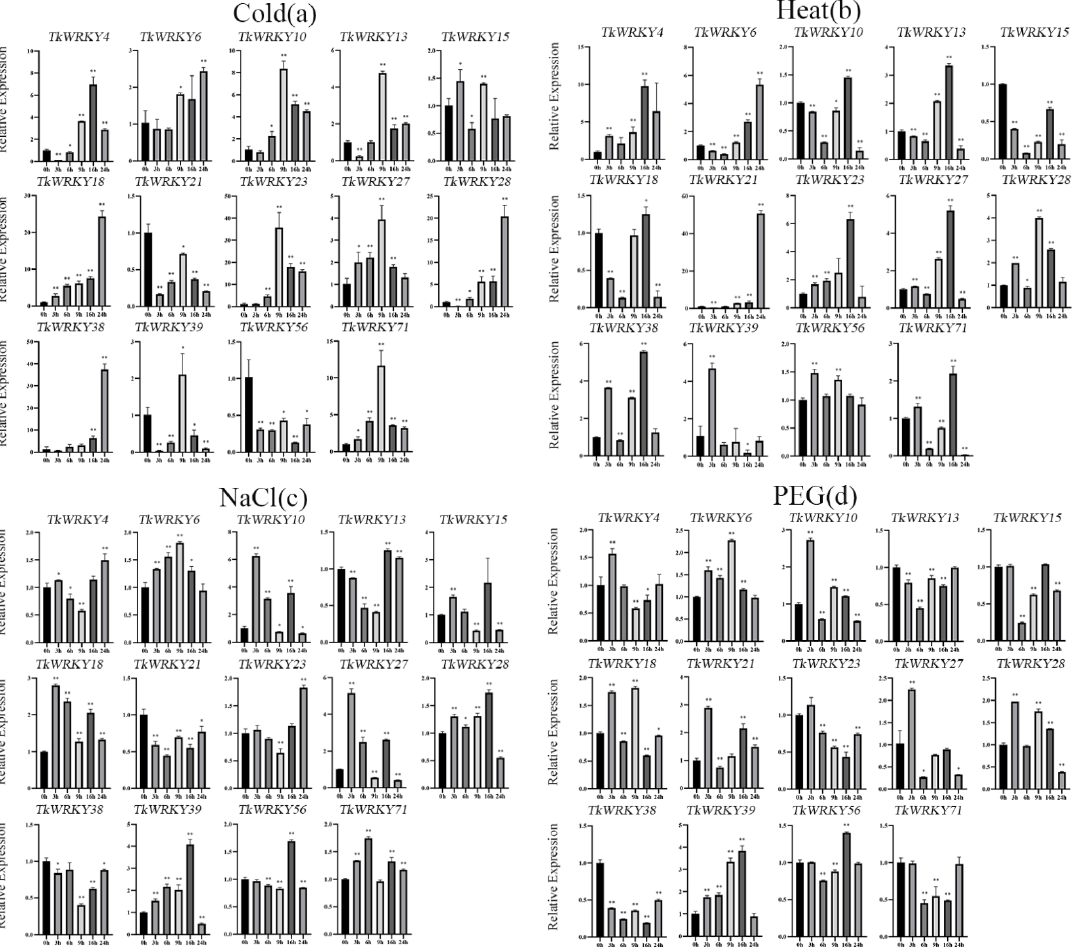
Figure 8. Modulation of gene expression of 14 TkWRKY genes at 0 (control), 3, 6, 9, 16, and 24 h after ( a ) cold, ( b ) heat, ( c ) salinity, and ( d ) osmotic stress. Data were normalized to β -actin and glyceraldehyde-3-phosphate dehydrogenase ( GAPDH ). Vertical bars indicate the standard deviation whereas an asterisk indicates the summary of the p value of the independent sample T-test of the corresponding gene compared with the control (* p < 0.05, ** p < 0.01).